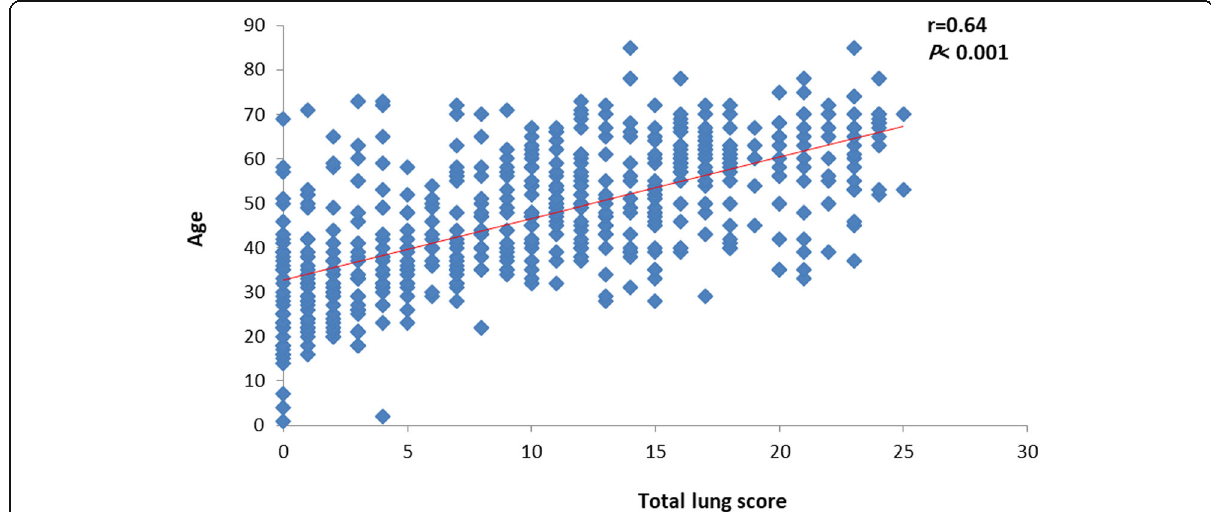
Fig. 1 Correlation between total lung score and